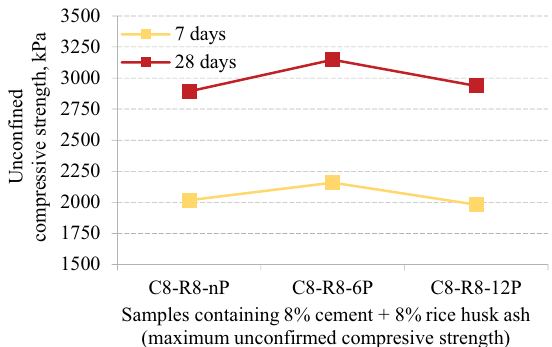
Figure 7. The unconfined compressive strength of samples stabilised using 8% OPC + 8% RHA for different PP